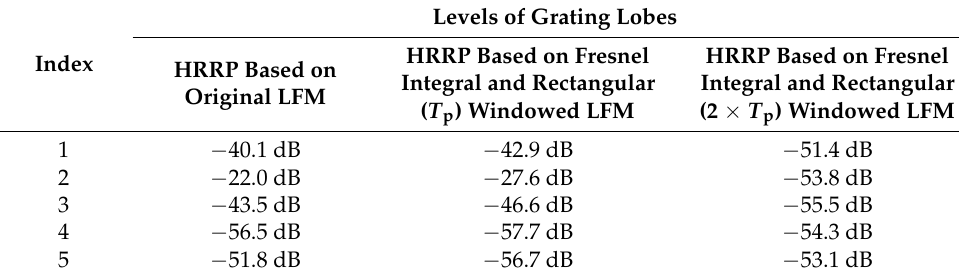
Figure 13. ( a ) Synthesized HRRP based on the original and windowed LFM pulses; ( b ) relationship between the levels of highest grating lobes and the width ratio of the additional rectangular window to LFM pulse with the stepped frequencies. Table 3. Grating-lobe levels based on the original LFM subpulse and the proposed windowed LFM subpulse in Figure 13a.